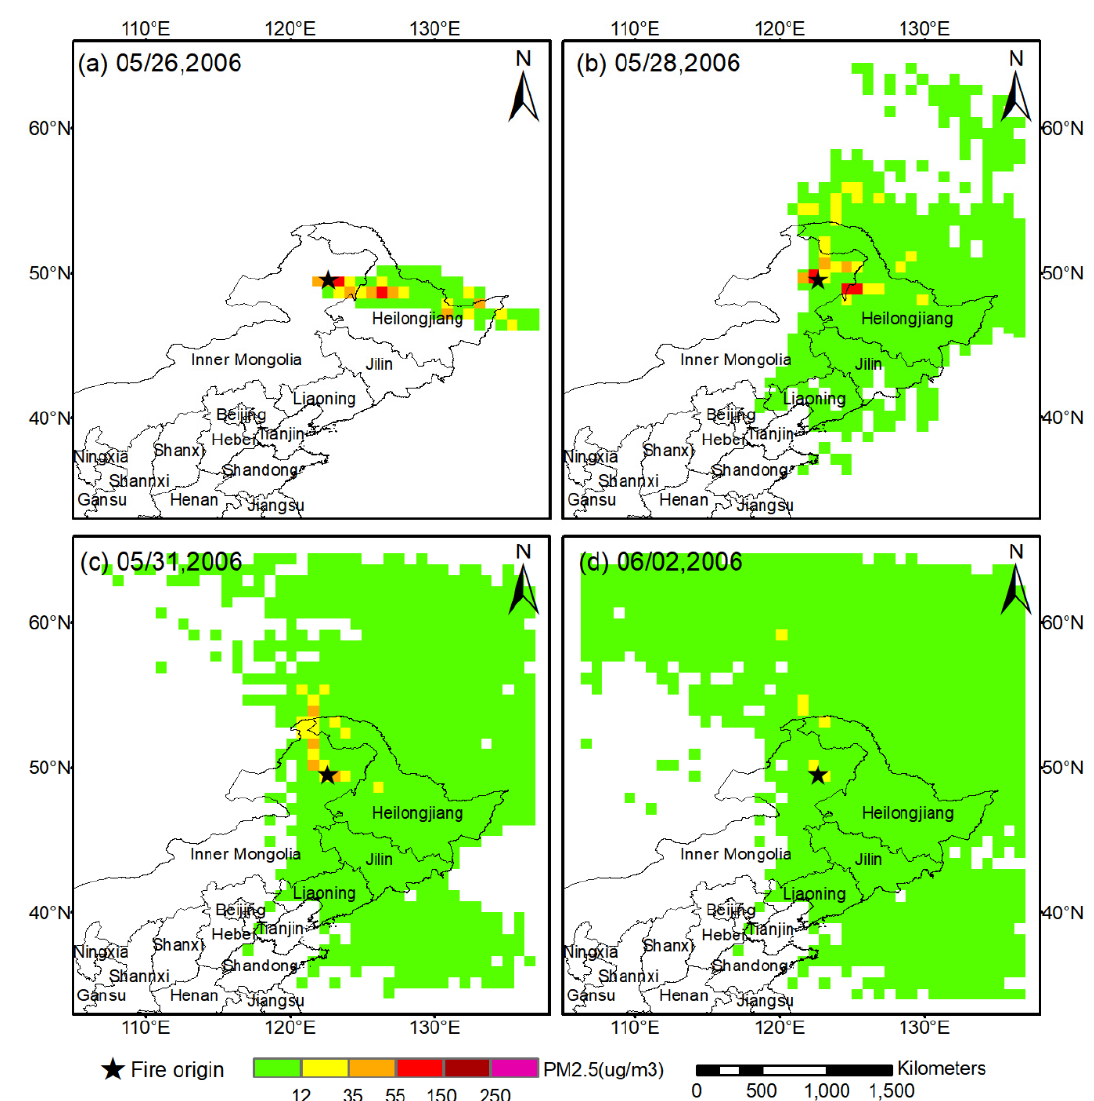
Figure 4. Same as Figure 3 except for the Wuerqihan fire. Panels ( a – d ) are 26, 28, 31 May and 2 June 2006, respectively.